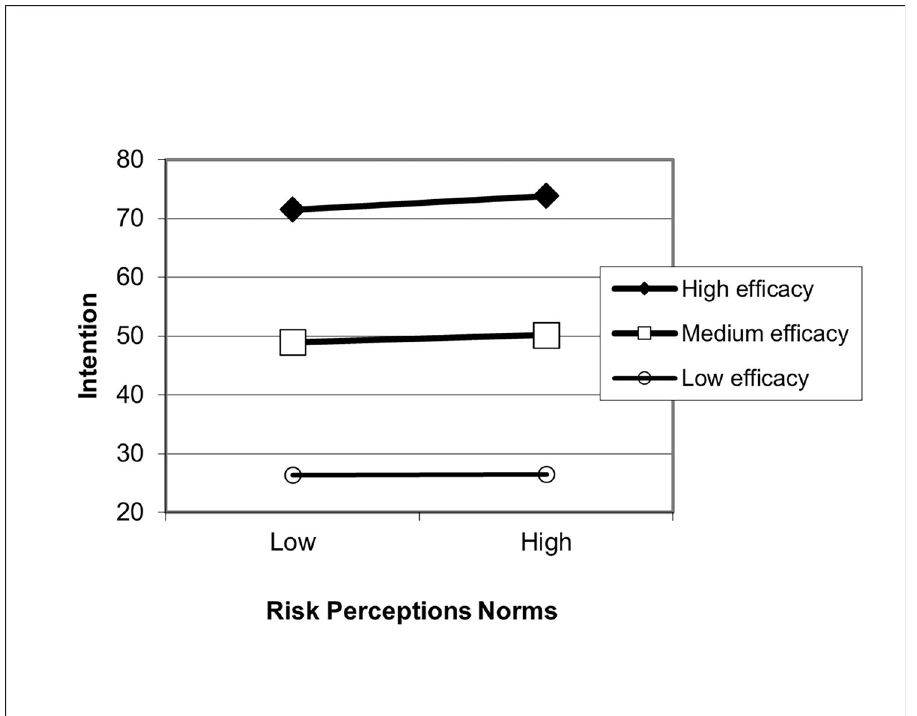
Fig 4. Relationship between risk perceptions and intentions moderated by efficacy beliefs. The interaction between risk perception and efficacy in predicting intentions is plotted here. Risk perceptions are plotted on the x-axis; intentions is plotted on the y-axis. The best fitting line for intention regressed onto risk perceptions is shown by varying levels of efficacy. High efficacy is defined as 1 standard deviation above the mean, medium efficacy is defined as the mean, and low self-efficacy is defined as one standard deviation below the